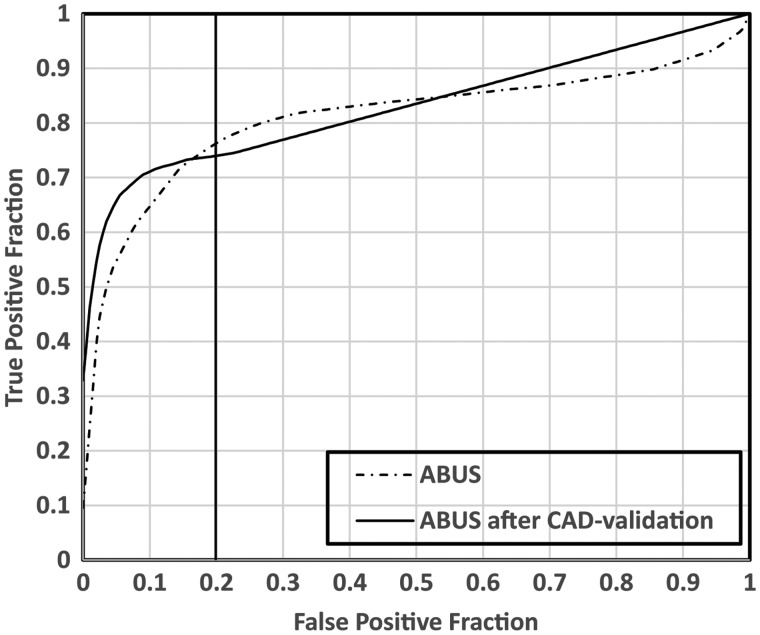
AFROC curves for both standard ABUS reading and results of
ABUS reading after CAD validation of human-observed
findings. In the higher specificity ranges (false-positive
fraction = 1 – specificity) results of reading ABUS with
CAD validation outperform standard ABUS reading. The
vertical line indicates the specificity of the pAUC
estimations are in the range of 80%–100%.